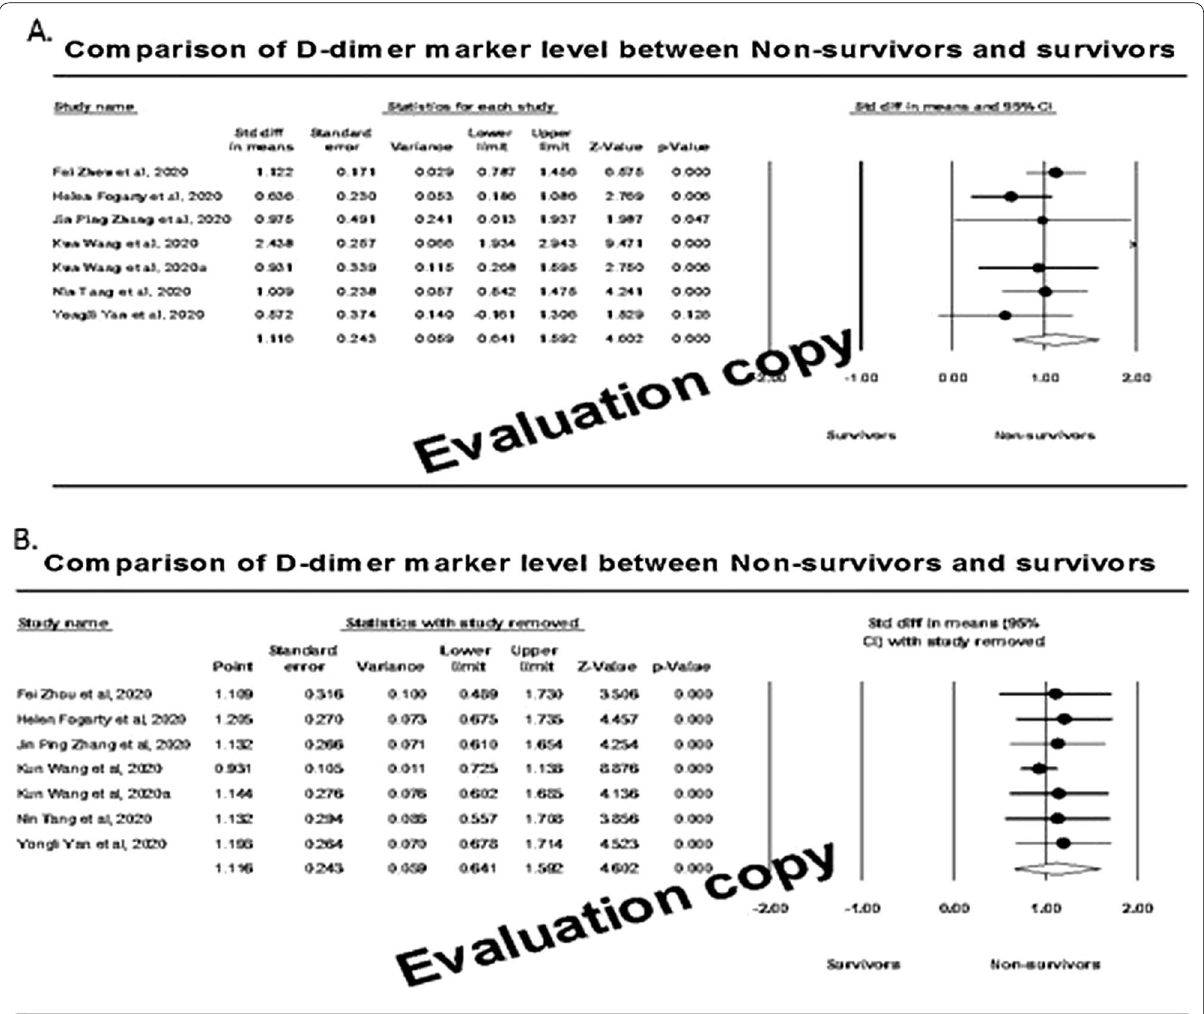
Fig. 5 Forest plot ( A ) and sensitivity analysis ( B ) of effect size among survivors and